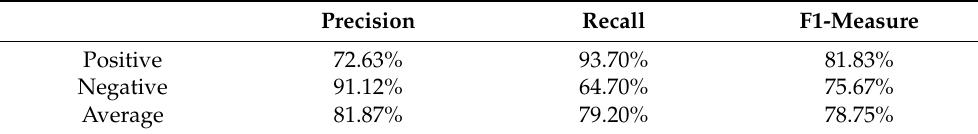
Table 18. Performance evaluation of ontology with level and frequency importance approach. Precision